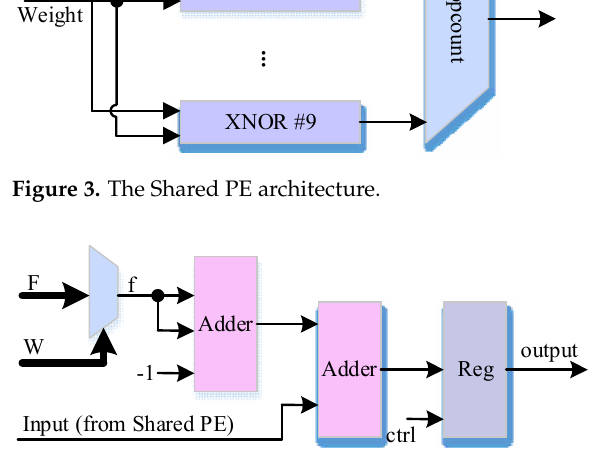
Figure 4. The architecture of KIS PE.